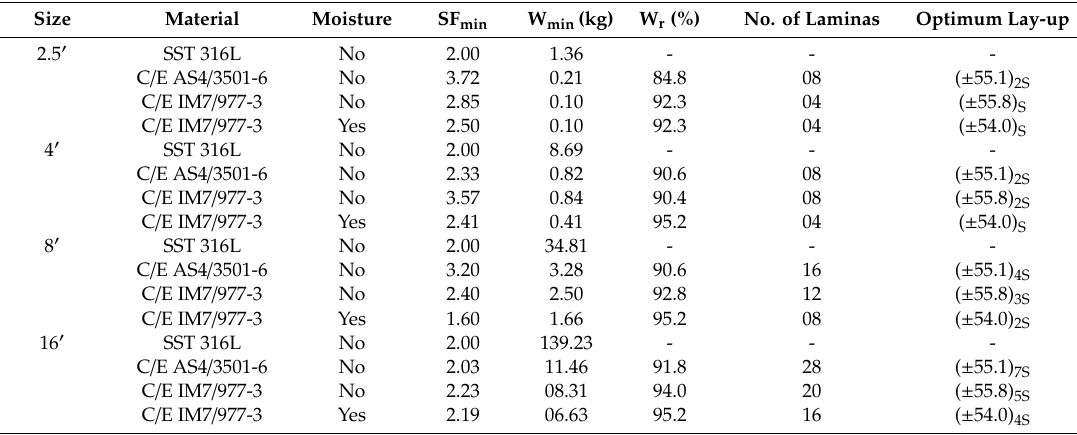
Table 4. Weight, safety factor and optimum lay-up comparison for all